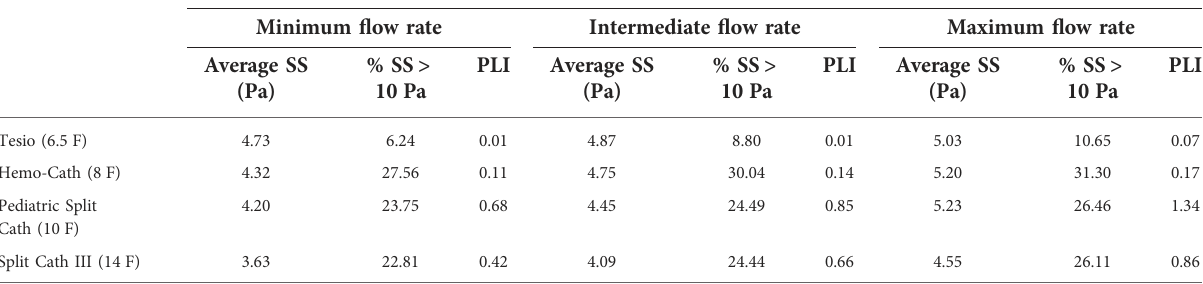
TABLE 3 Shear stress levels and PLI values for all the four CVL models at each fl ow rate.